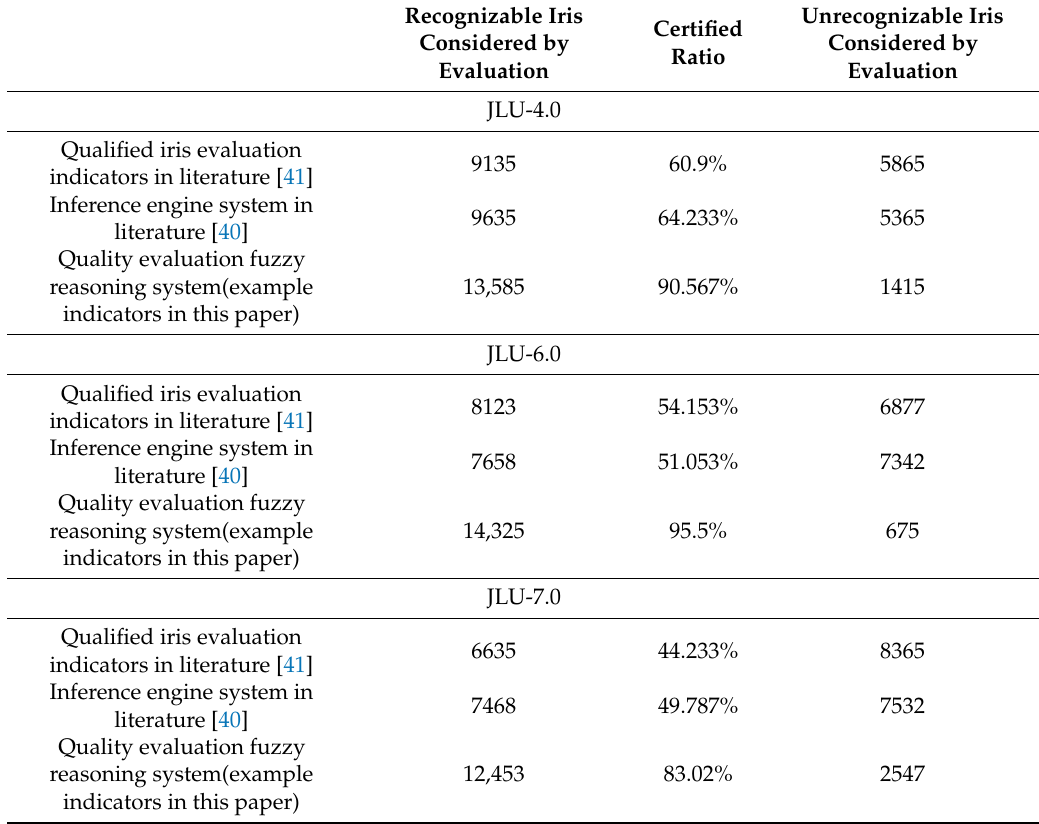
Table 20. The number of qualified irises in the three iris libraries developed in three di ff erent ways.